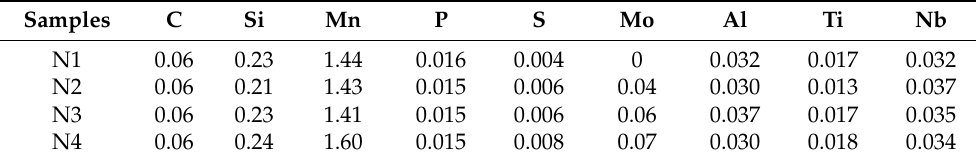
Table 1. Chemical composition of the steels (wt %).